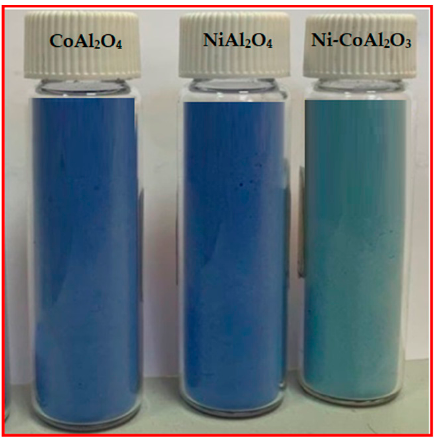
Figure 5. Bimetallic catalysts based on Ni, Co, and γ -Al 2 O 3